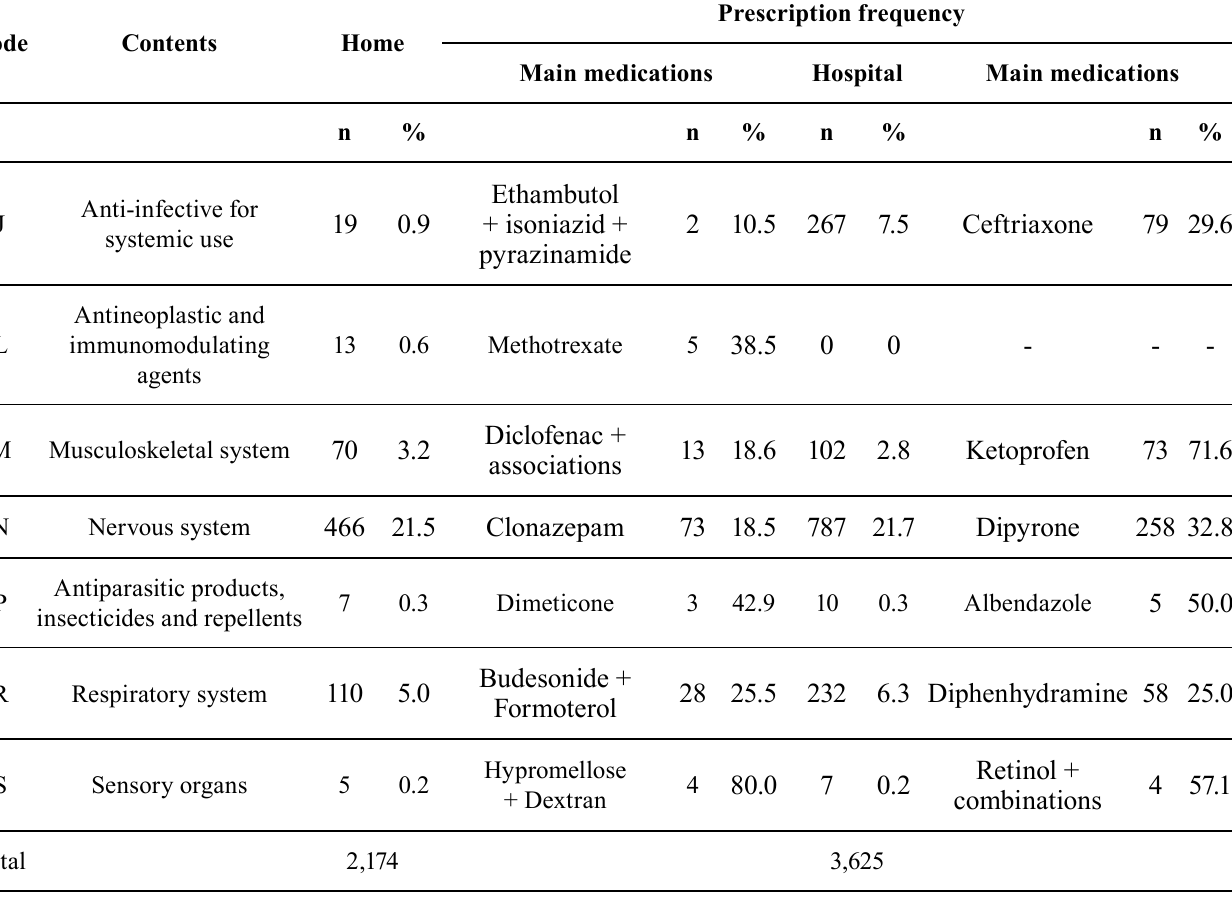
TABLE II – Most frequently prescribed drugs of the classes used in the home and hospital prescriptions by study participants hospitalized in the period from 2015 to 2016